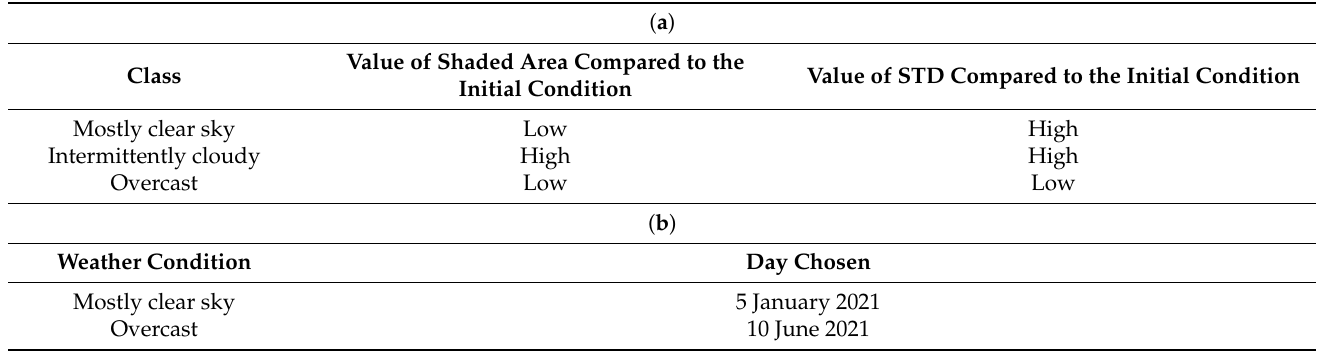
Table 5. ( a ) Conditions used for classification. ( b ) Dates chosen for initial